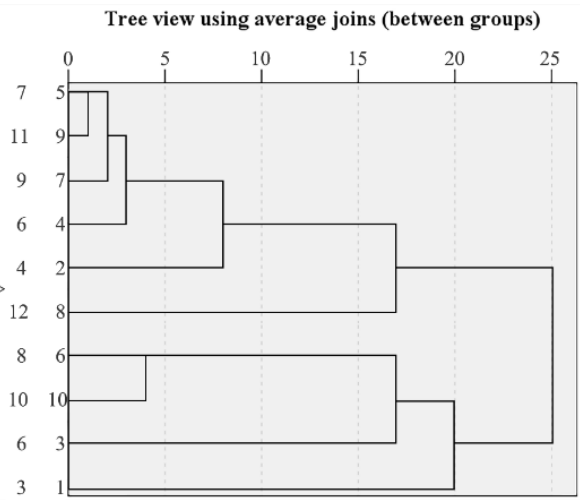
Figure 9. Cluster analysis of Permian sandstone fissure water system.